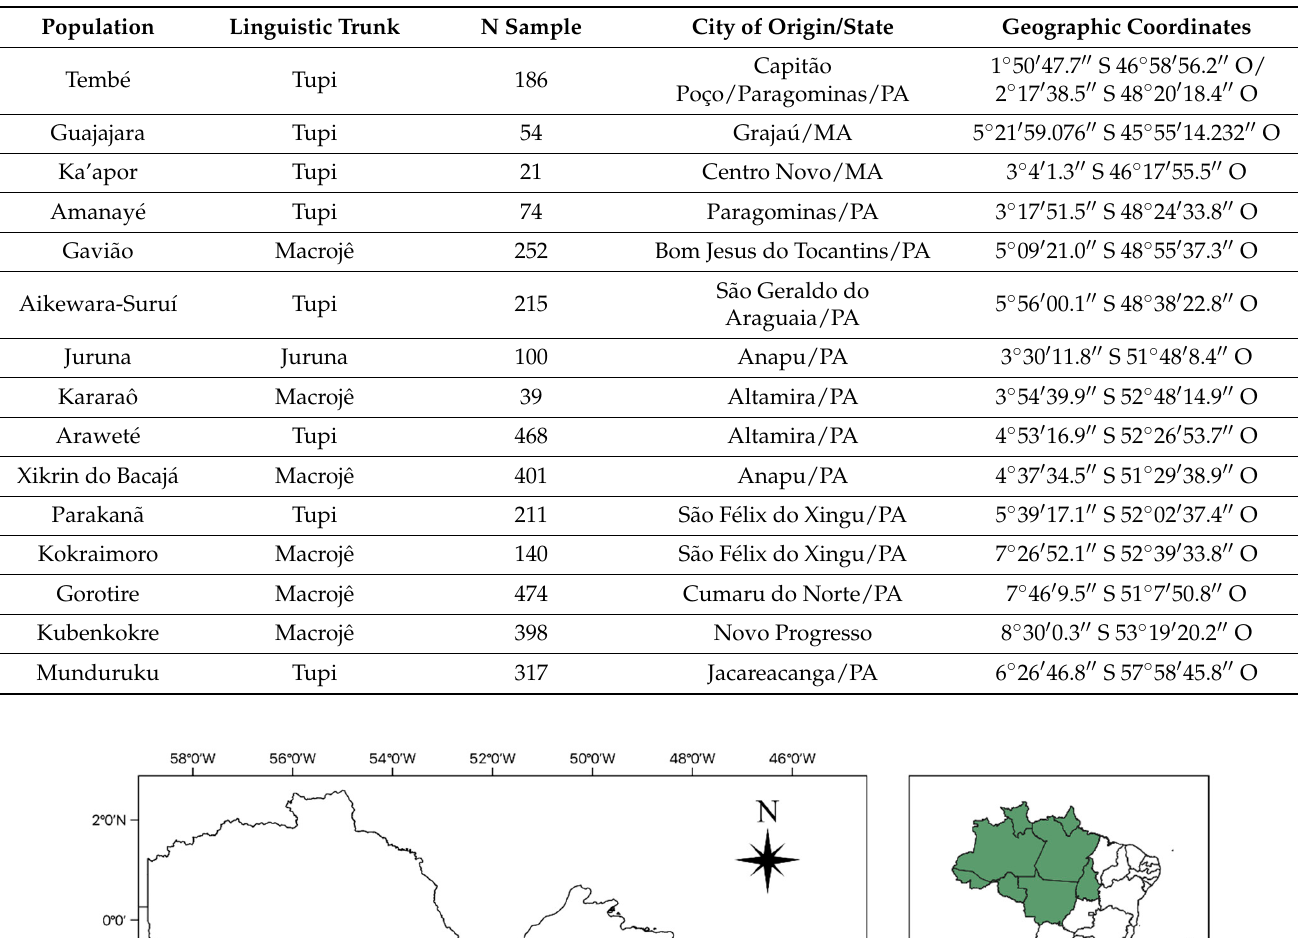
Table 1. Description of the people studied in the present study.